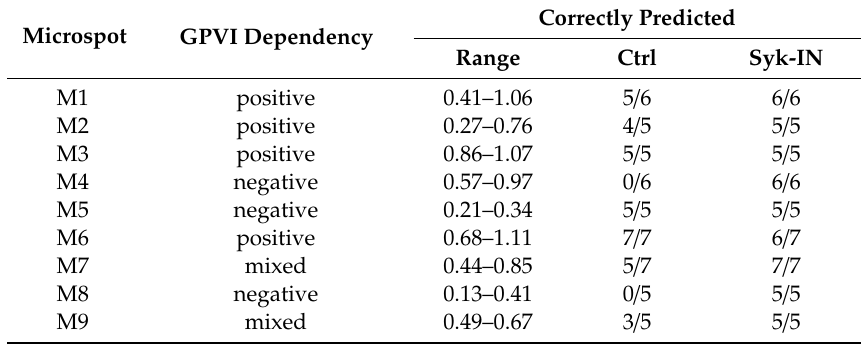
Table 2. Modeled partial least square (PLS) analysis (based on component 1 principal